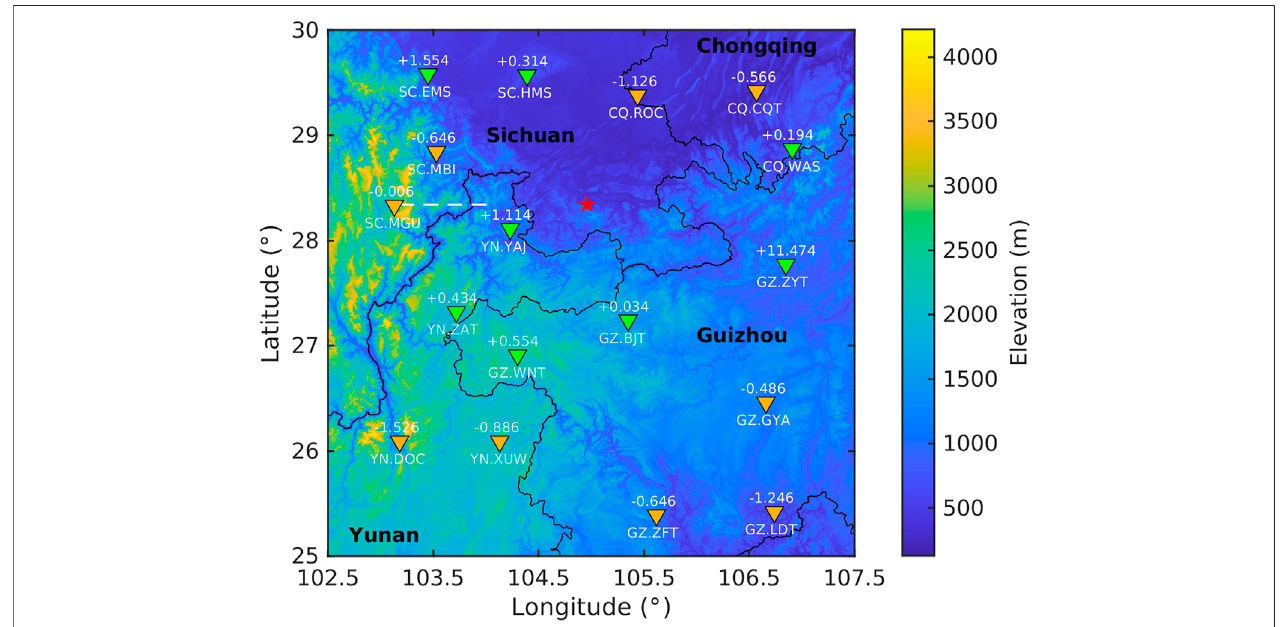
FIGURE 2 | The topography in the study along with the centroid location of the Changning earthquake (red star) and 17 broadband stations (triangles) in the four provinces (black texts) of China. The white numbers above the triangles are the z-component time shifts of surface wave at stations (positive in green and negative in yellow) in Figure 10 . The whitetexts belowthe trianglesdenote the names ofseismic network and stations and the white dashed linemarks the location ofgrid pro fi le in Figure 5 .